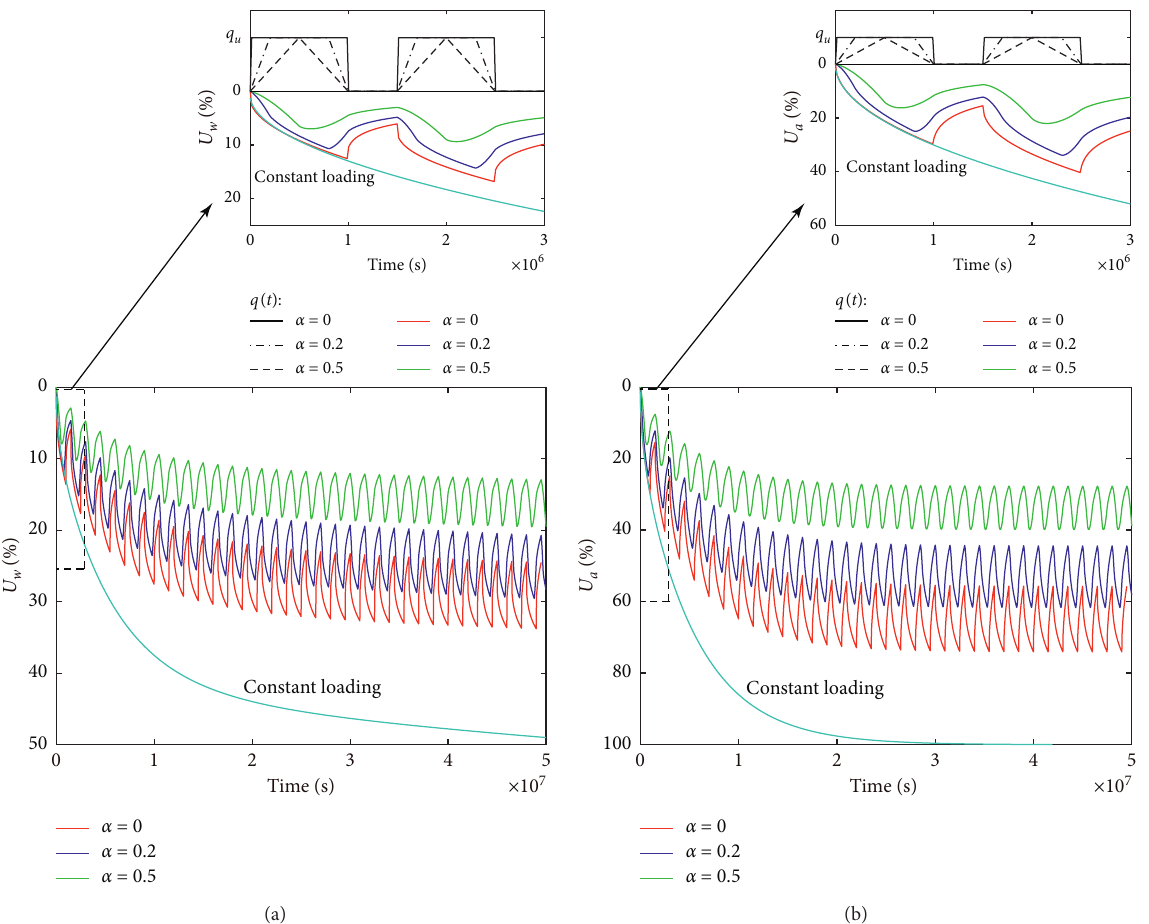
Figure 10: The effects of α on consolidation of unsaturated soils under various cyclic